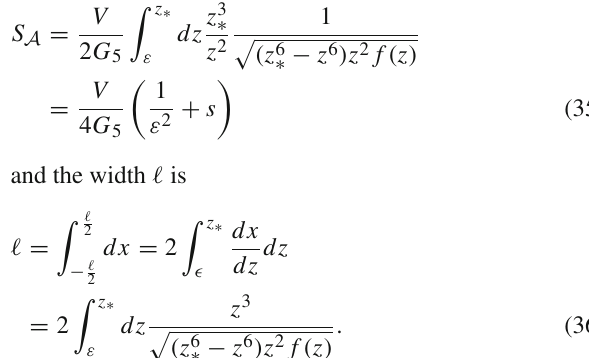
Fig. 7 The HEE with respect to the temperature T for different param- eters b and (cid:2) . In left panel,the black line is for | b | = 0 . 0, the blue line is for | b | = 0 . 4 , the red line is for | b | = 0 . 6, and green line is for